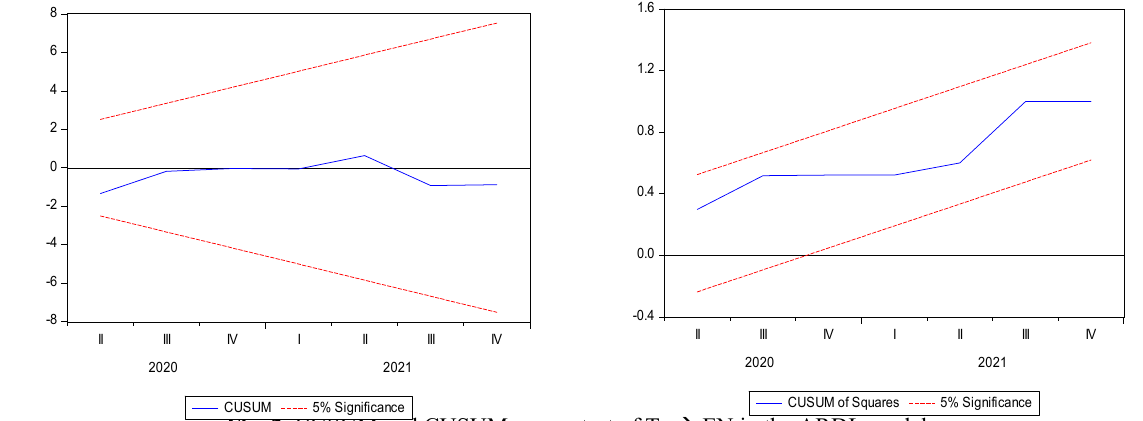
Fig. 2. CUSUM and CUSUM square test of Tr  EN in the ARDL